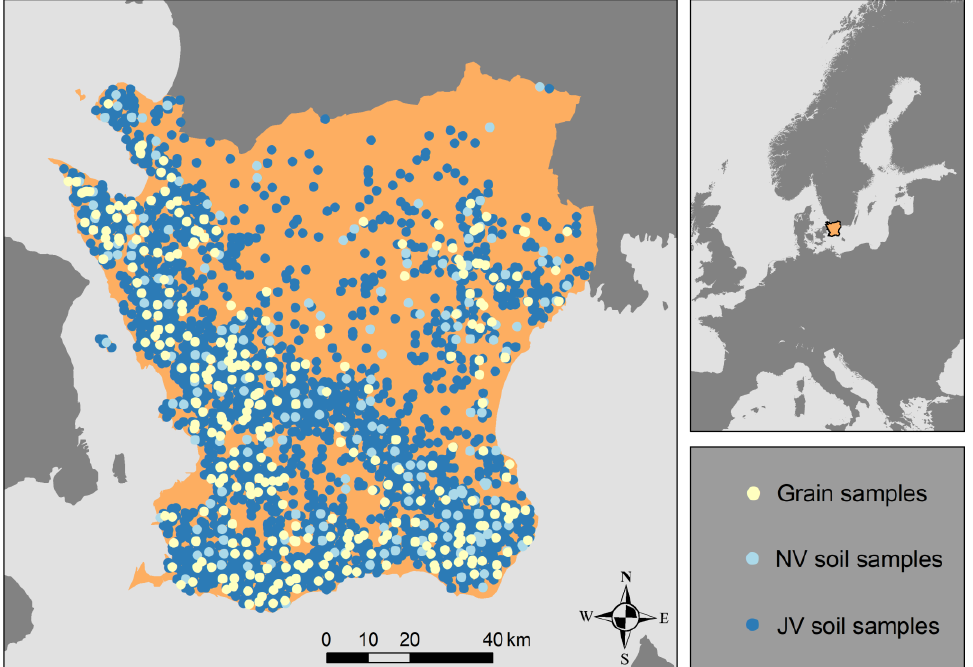
Figure 1. Maps showing the location of the study area (Skåne County in southern Sweden) and the data-collection points. NV (Naturvårdsverket) soil-sampling sites ( n = 304), from which laboratory- measured cadmium data were used to calibrate the portable X-ray fluorescence and the digital soil mapping (DSM) model, are presented as light blue dots and JV (Jordbruksverket) sampling sites ( n = 2097) as dark blue dots. Combined data from the JV and NV samples were used to calibrate the DSM model. Sites from which laboratory data on cadmium concentrations in wheat grain samples were available ( n = 307) are presented as light yellow dots.